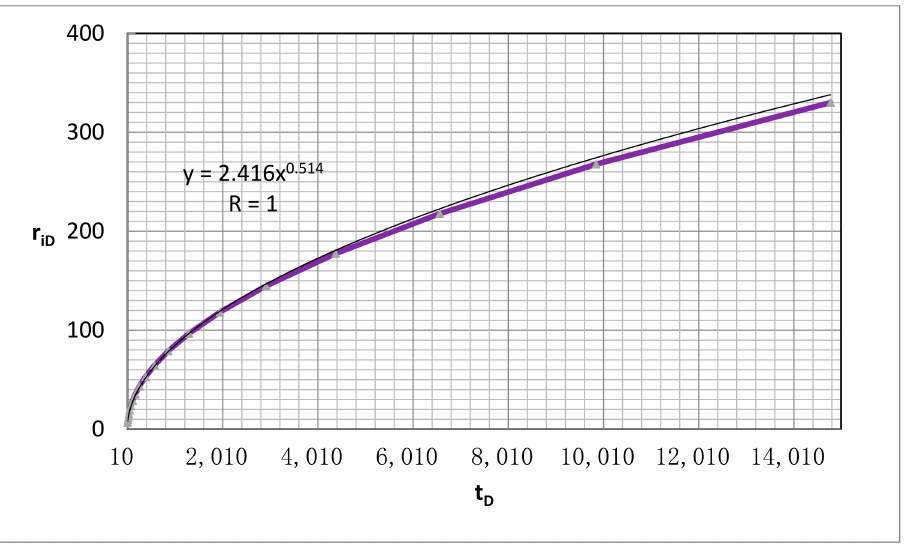
Figure 5. Relationship between sweep radius and time in low-permeability reservoirs (G = 5 × 10 − 4 ). The coefficient a and exponent b linear fitting curves were drawn under different starting pressure gradients (Figures 6 and 7). The fitting results indicate that the linear model can reach a higher fitting accuracy (Table 4, R exceeds 0.998), and the linear model can be used for an approximate